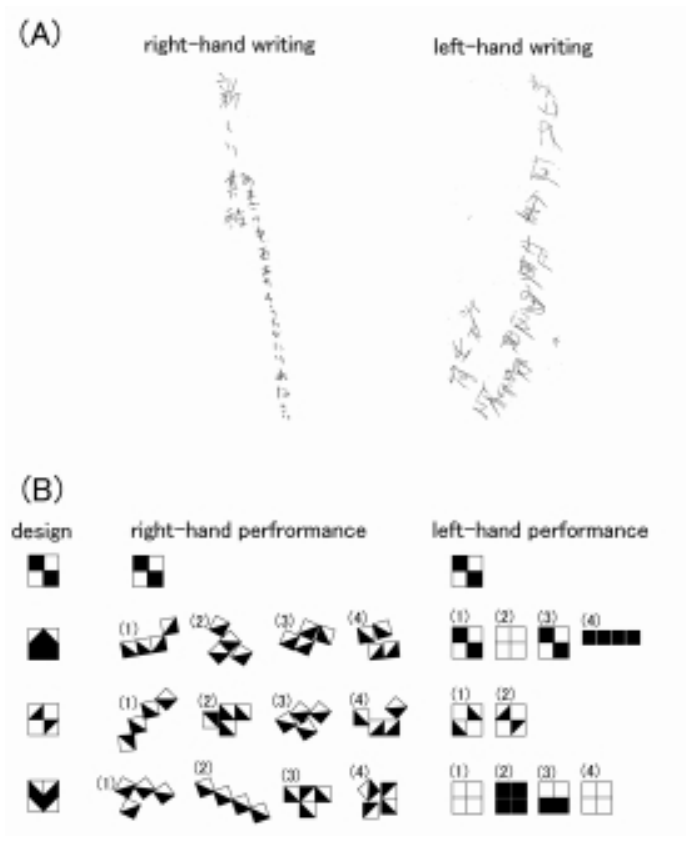
Fig. 2. (A) Examples of the writing to dictation by the patient. The sentence written by his right hand showed no abnormality except for a few errors of Kanji (ideogram) characters (due to his low level of education) and a few errors of Kana (phonogram) letters (due to mishearing). In contrast, the sentence written by his left hand consisted of incorrect letter-like items, most of which resembled real Kanji characters or incorrect combinations of Kanji parts. (B) Examples of the block design by the patient. Numbers in parentheses indicate the temporal order of his responses when he was requested to construct with the blocks the design depicted in the left column. In three out of four trials, his right hand could not reproduce the correct designs. The global shape of the design (a square) was also not constructed. His left hand failed to reproduce the correct designs, but succeeded in constructing the global shape of the design as a